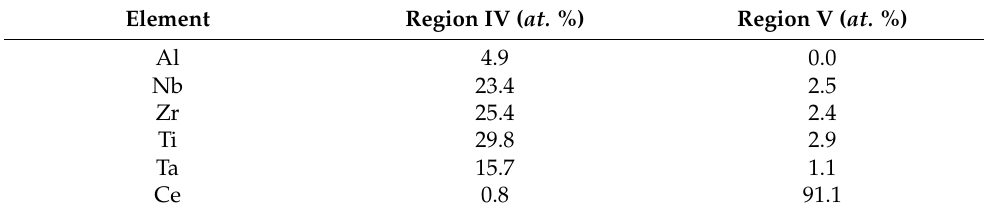
Table 2. Element distribution in different regions in TEM images. Element